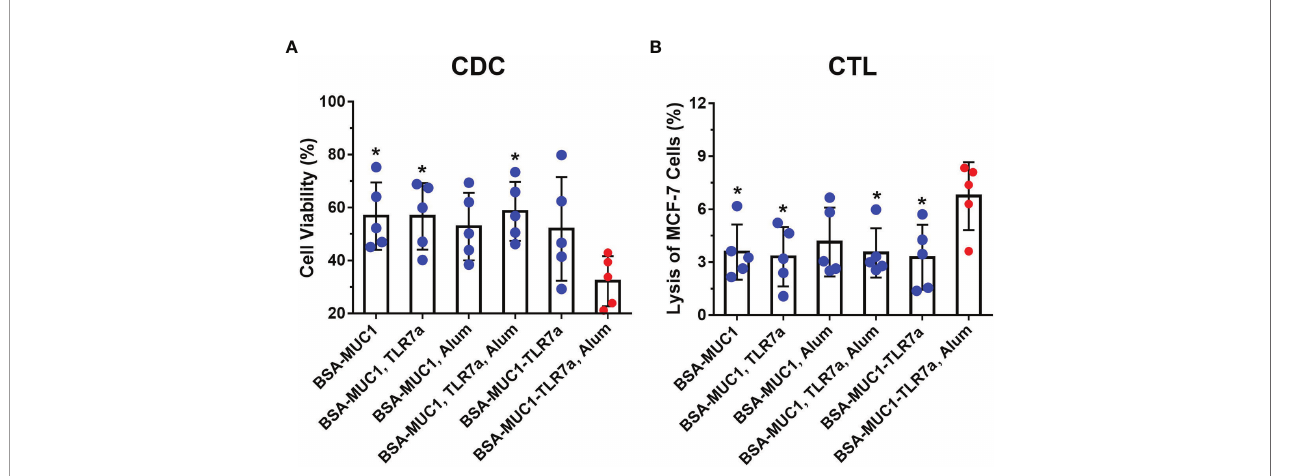
FIGURE 4 | (A) The complement-dependent cytotoxicity (CDC) assay of sera from vaccinated mice (MCF-7 cells). (B) The cytotoxic T-lymphocyte (CTL) assay of spleen from vaccinated mice on day 42. The data are expressed as the mean ± SEM. Asterisks show signi fi cant difference compared with BSA-MUC1-TLR7a/Alum group based on one-way ANOVA by Dunn ’ s multiple comparison test (*P ≤